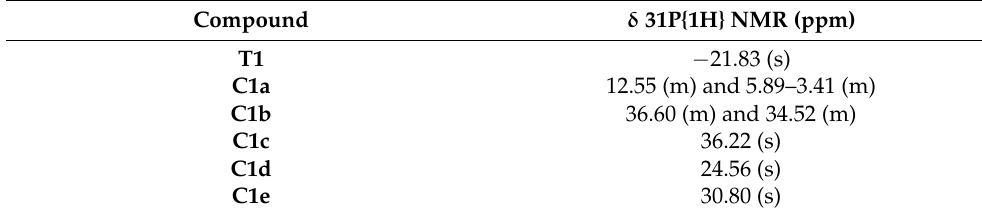
Table 1. 31 P{ 1 H} NMR (ppm) data for T1 and complexes C1 .